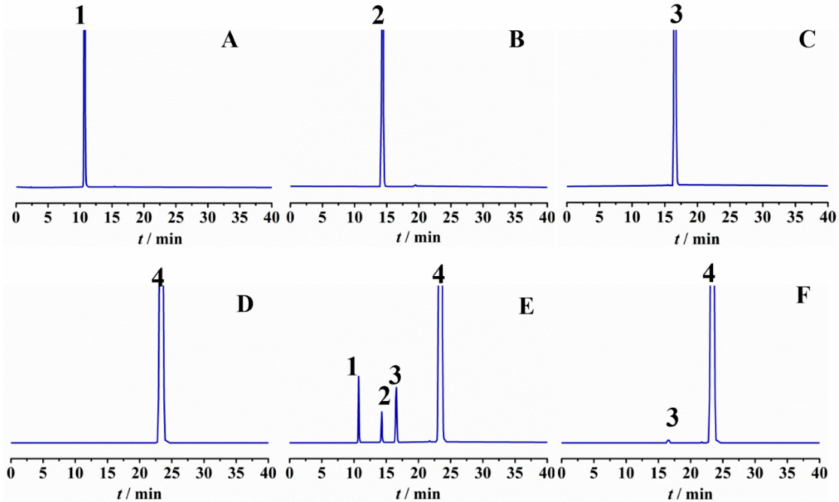
Figure 2. Detection of related substances in LM49-02 by HPLC method B. ( A ) LM49-01 reference substance. ( B ) LM49-02-imA reference substance. ( C ) LM49-02-imB reference substance. ( D ) LM49-02 reference substance. ( E ) LM49-01 / LM49-02-imA / LM49-02-imB / LM49-02 reference substance mixture. ( F ) LM49-02 test sample.